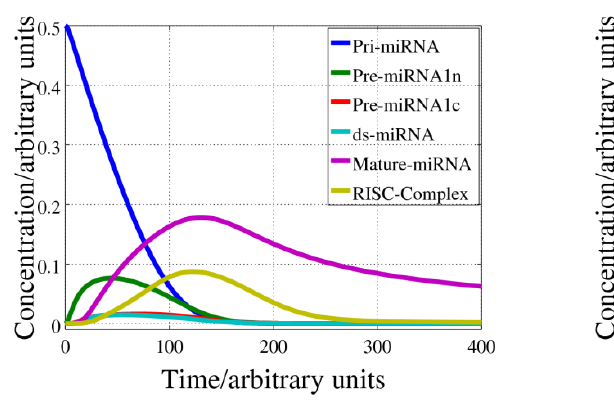
Figure 3: miRNA biogenesis simulations. Only six metabolite concentration profiles are shown. Only pri-miRNA has a non- zero initial concentration in the simulation.